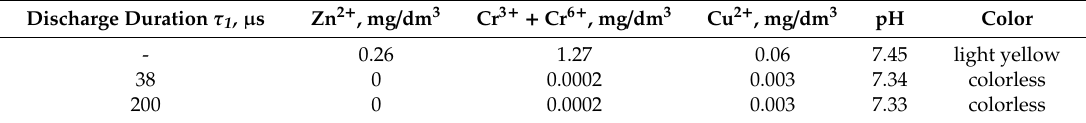
Table 4. The e ffi ciency of galvanic purification in the process of changing the duration of pulse discharge. Discharge Duration τ 1 , µ